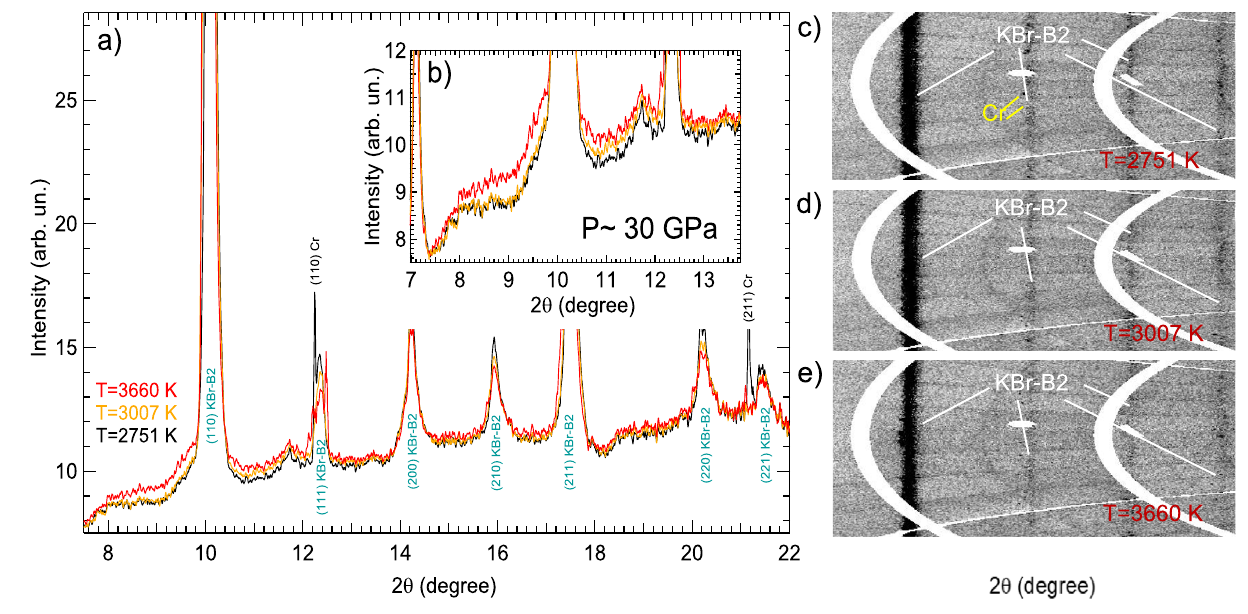
Figure 1. ( a ) Integrated XRD patterns at different T around 30 GPa and ( b ) corresponding zoomed region around the XRD diffuse signal. The onset of melting, characterized by the first appearance of the diffuse signal, is observed at 3007 K (orange pattern). The diffuse scattering increases with the rising T , showing its maximum at 3660 K (red pattern). ( c – e ) unwrapped raw XRD images showing the textural evolution of a Cr sample embedded in KBr pressure transmitting medium at around 30 GPa. The signals arising from the different components are highlighted with different colours: yellow for the Cr and white for the KBr-B2. T is also indicated in